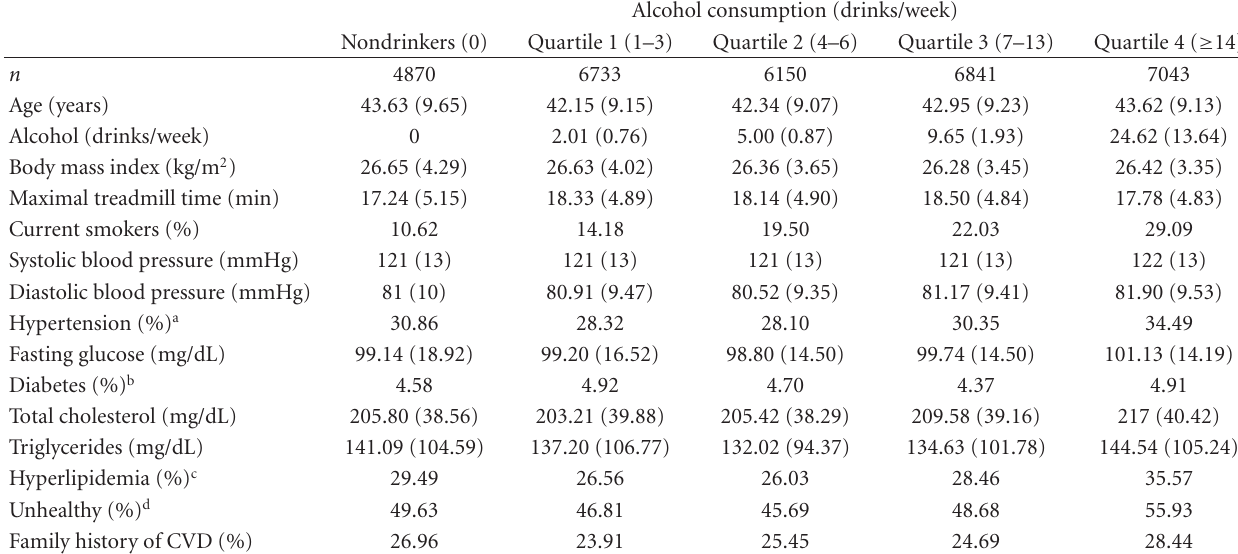
Table 1: Baseline demographics by alcohol consumption level, Aerobics Center for Longitudinal Study (ACLS), 1974–2002.